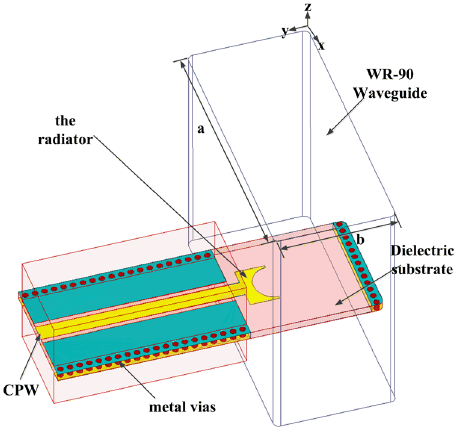
Figure 1. Configuration of proposed transition.